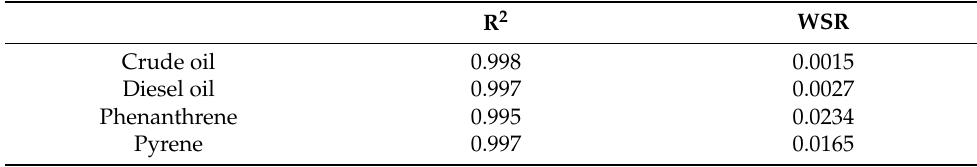
Figure 2. The solubility increases linearly of phenanthrene, pyrene, diesel oil and crude oil. Table 1. Linear regression of solubility enhancement curve. Table 1. Linear regression of solubility enhancement curve. R